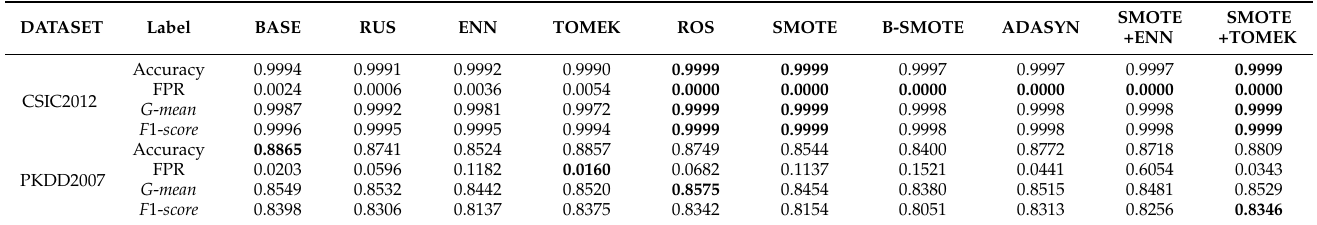
Table 6. Model performance results after binary sampling (datasets CSIC2012 and PKDD2007, algorithm XGBoost).